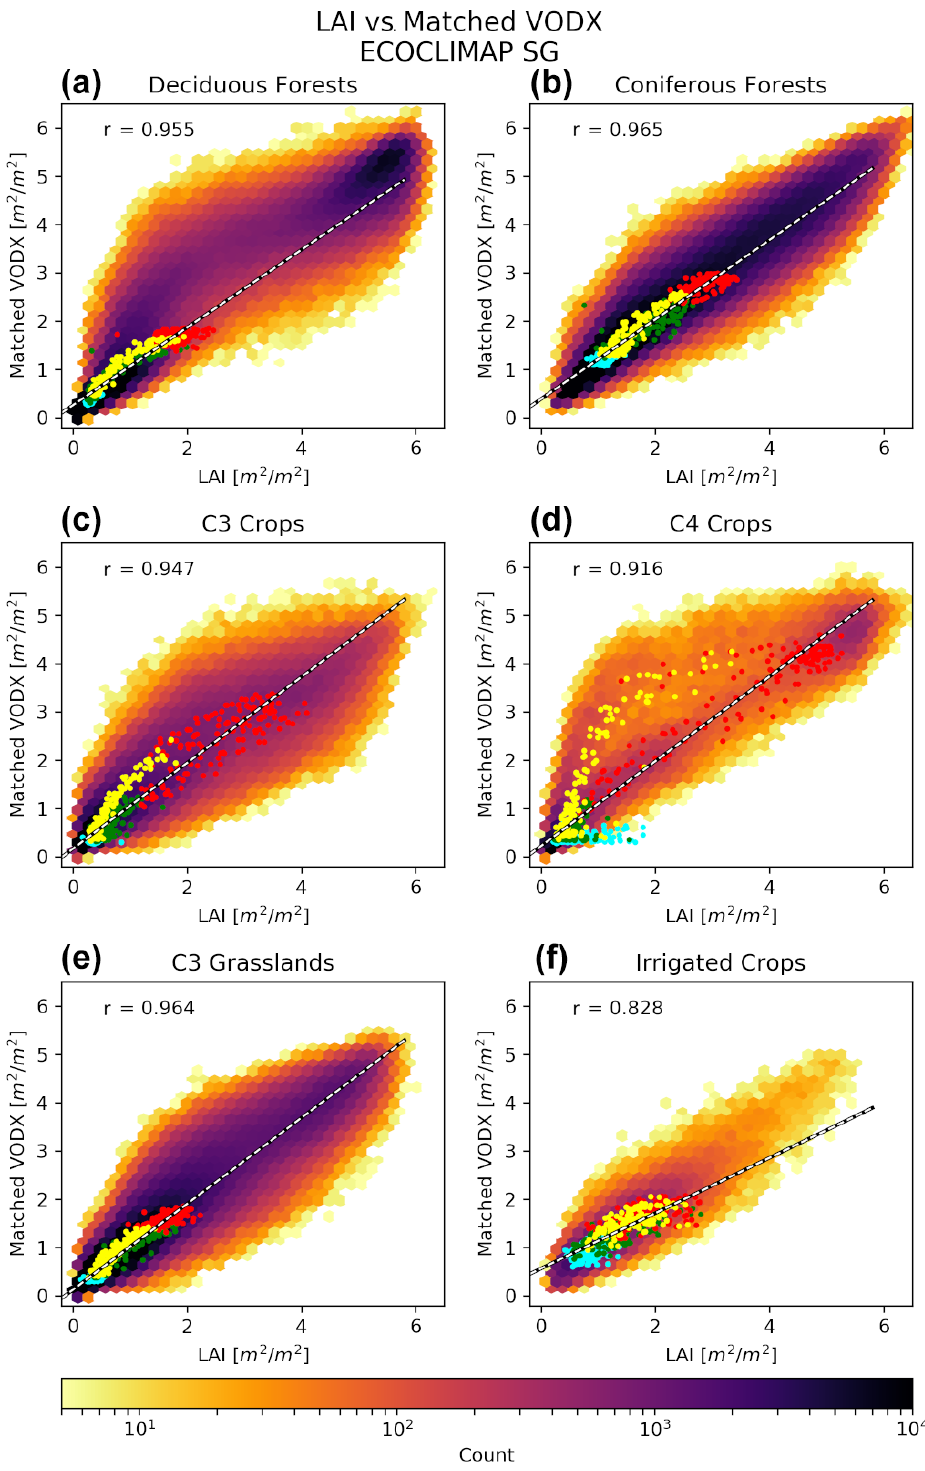
Figure 6. Density scatterplots detailing the relationship between LAI and matched VODX from VODCA over six dominant vegetation types: (a) deciduous forests, (b) coniferous forests, (c) C 3 crops, (d) C 4 crops, (e) C 3 grasslands, and (f) irrigated crops for the years 2003 to 2018. Dominant vegetation is defined as where 50% or more of a patch contains a single vegetation type. Higher concentrations of points trend towards black. Colored dots represent the spatial average each time an LAI–VOD comparison is made over the four seasons, where cyan is winter, green is spring, red is summer, and yellow is autumn. Dashed black-and-white dashed lines represent the linear regression of the seasonal